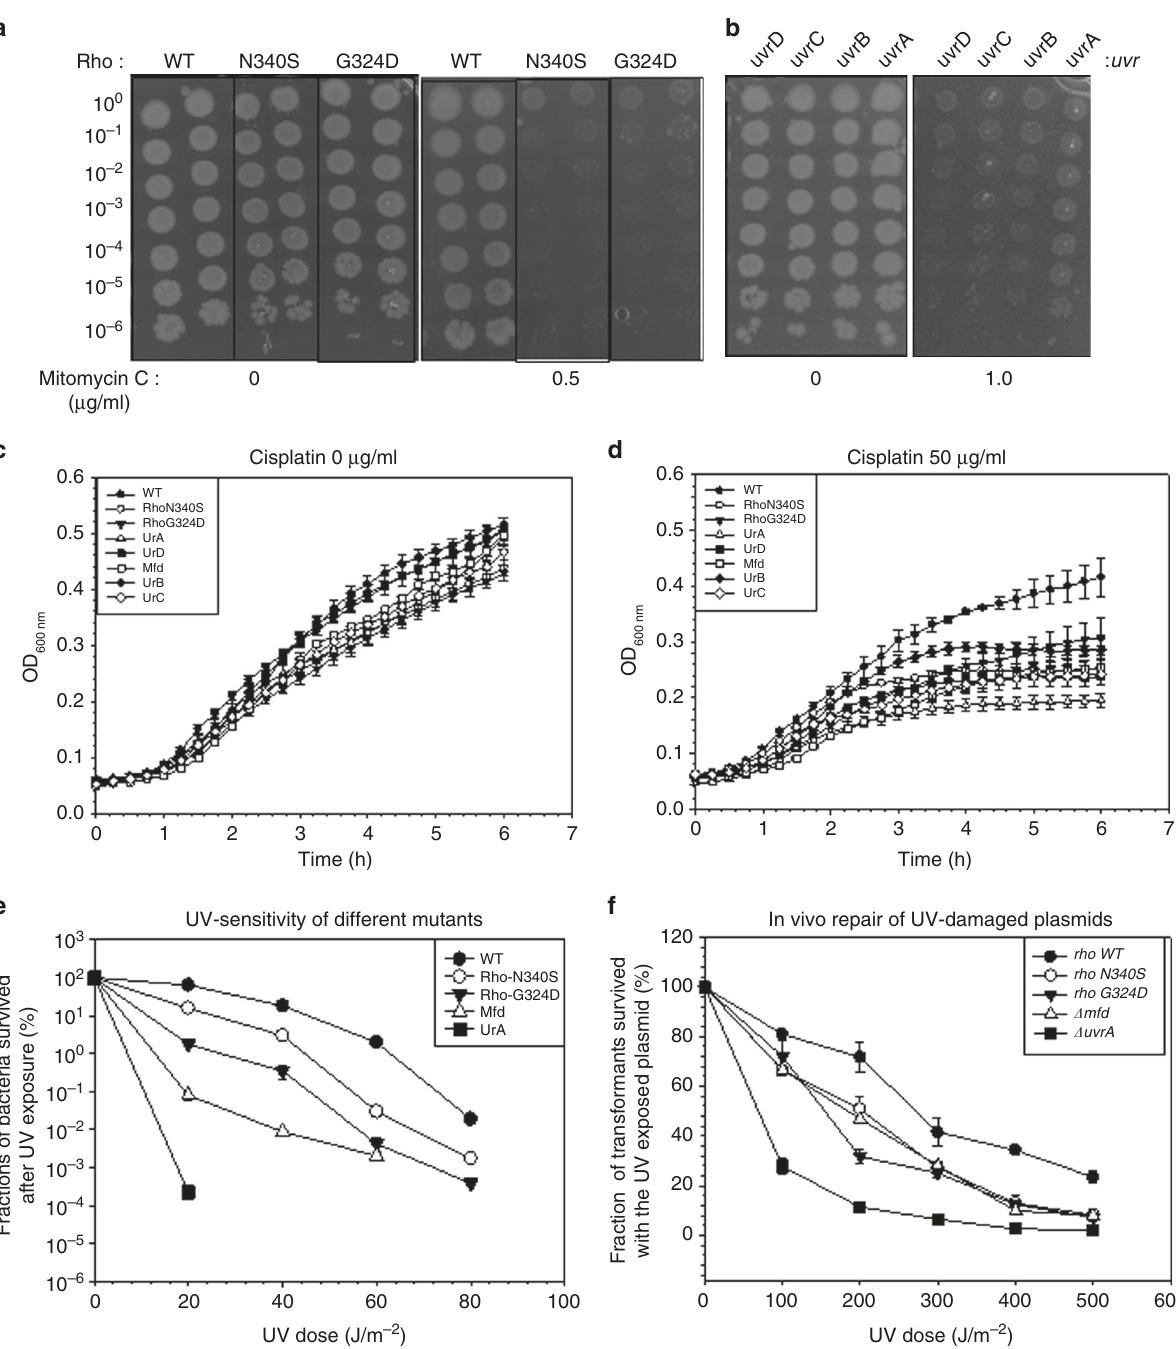
Fig. 3 Sensitivity of E. coli MG1655 strains expressing different Rho mutants and having deletions in each of the NER genes towards the NER-inducing agents. a and b Serial dilution of mid-log phase culture of different strains were spotted on the LB plates containing indicated concentrations of Mitomycin C. Rho mutants were more sensitive towards Mitomycin C (0.5 µ g/ml) as compared to the strains deleted for NER genes (1 µ g/ml). c , d Growth curves showing the effect of Cisplatin on different strains as indicated. Rho mutants and various uvr deletion strains showed high sensitivity towards cisplatin compared to the WT strain. e Effects of different UV doses on the survival of the MG1655 strains having indicated mutations. f In vivo repair of UV- damaged plasmids in different strains. The plasmid pBR322 exposed to the increasing doses of UV was transformed to the strains either expressing mutant rho or are deleted for either uvrA or mfd. Fractions of number of transformants obtained were plotted against the UV-dose used to damage the plasmid in vitro. 4 – 5 replicates of the same experiment were performed to calculate the standard error of mean. Source data are provided as a Source Data fi